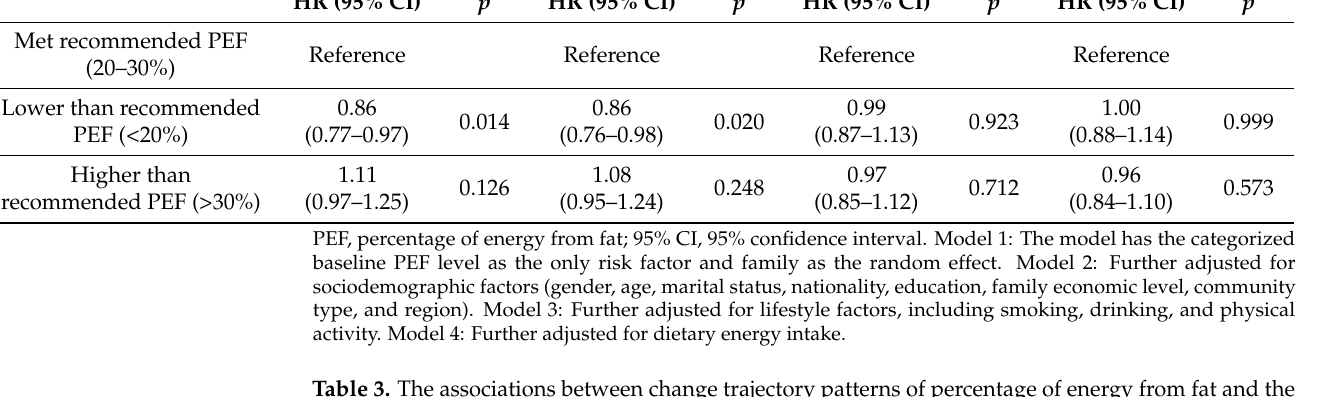
Table 3. The associations between change trajectory patterns of percentage of energy from fat and the risk of obesity: results of Cox proportional hazards regression models with shared